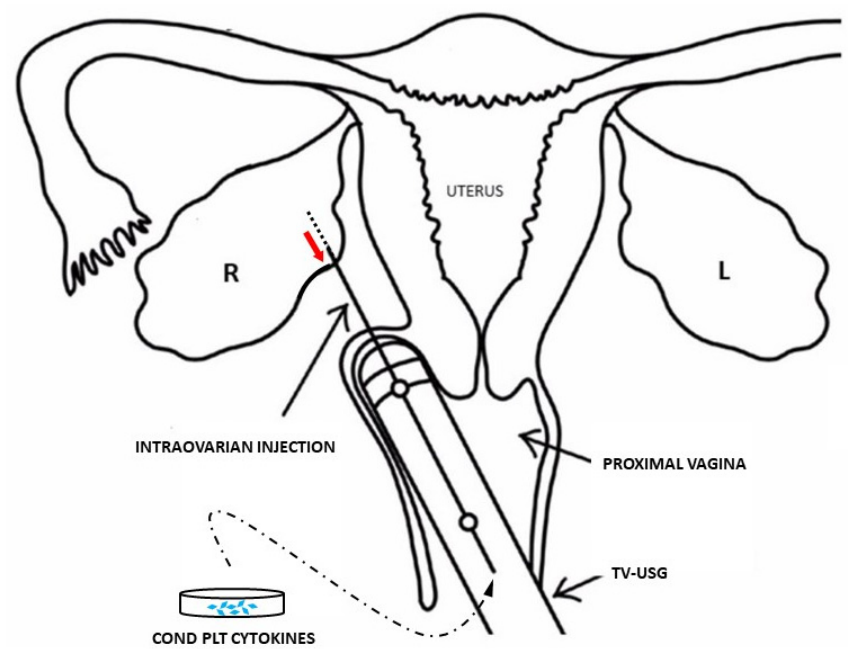
Figure 1. With technical features common to oocyte retrieval/ in vitro fertilization (IVF), one method is shown for ‘ovarian rejuvenation’ via placement of autologous condensed platelet cytokines (Cond PLT Cytokines) derived from activated platelet-rich plasma. This is placed into the ovarian cortex and subcapsular space by transvaginal ultrasound (TV-USG) upon needle withdrawal (red). Cyclic estradiol and progesterone production is expected to follow, with increased anti-Mullerian hormone output and subsequent emergence of competent de novo metaphase II oocytes